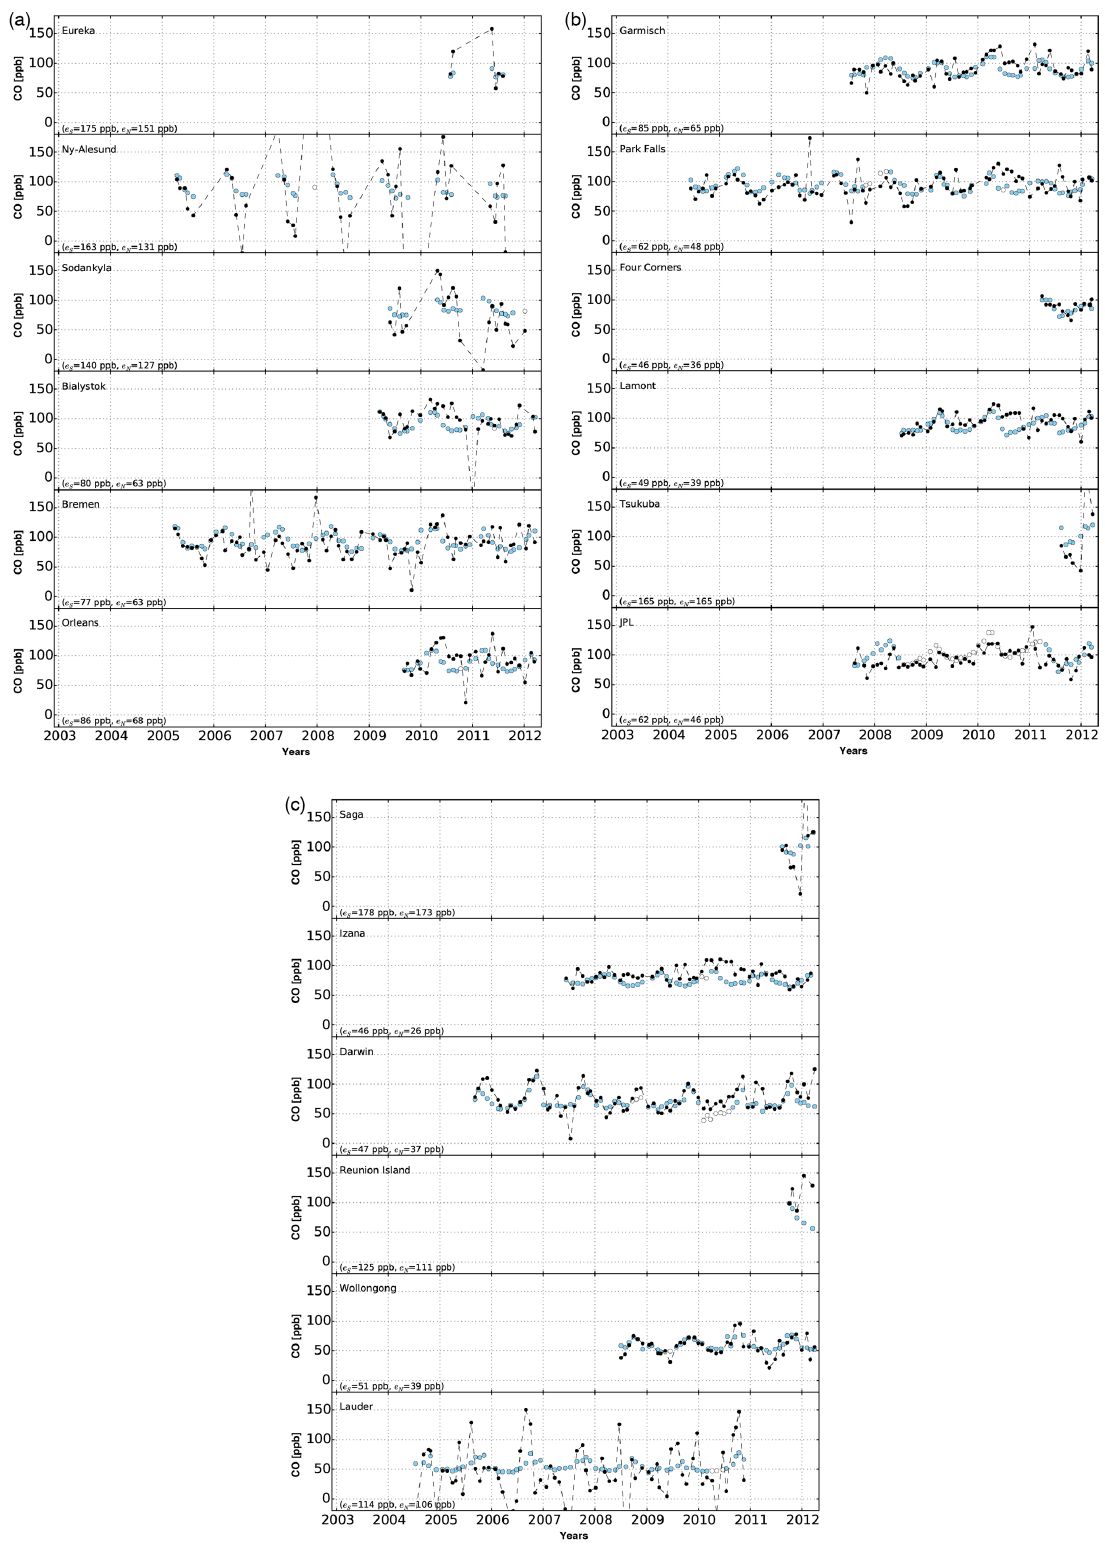
Figure 7. As Fig. 6, but for TCCON measurements indicated in blue. The GGG2014 release of TCCON was used but the stations Ny- Ålesund, Bremen and Four Corners are still based on